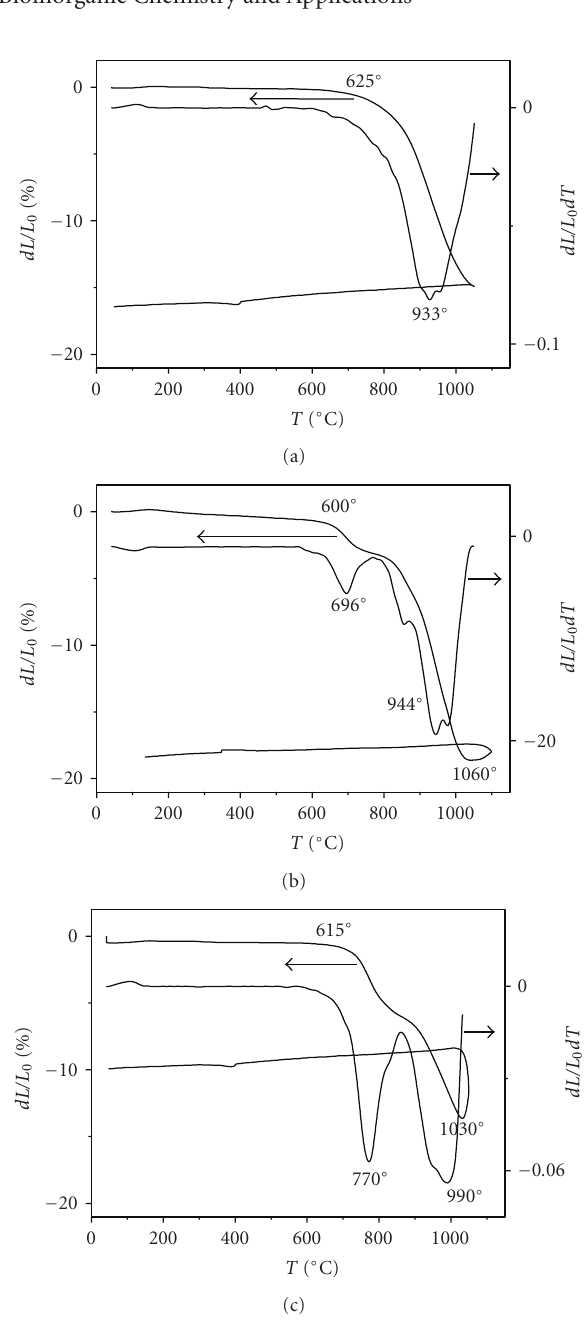
Figure 6: Shrinkage and shrinkage rate of M x FA samples as a function of temperature: (a) x = 0, (b) x = 1, and (c) x = 2.